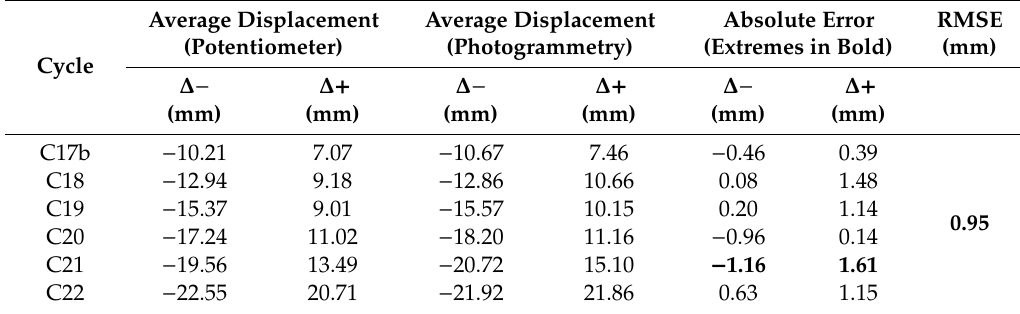
Table 10. Absolute errors obtained for the comparison between the average values of the peaks captured by target 1464 and sensor P4 after outlier